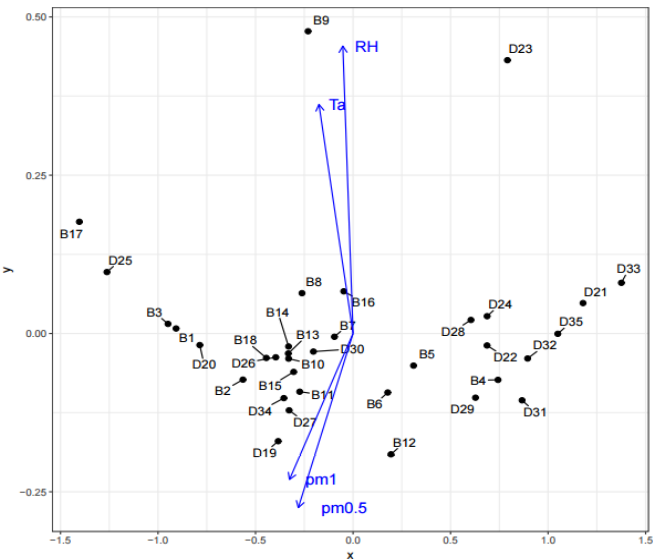
Figure 13. Dependence of continuous variables.